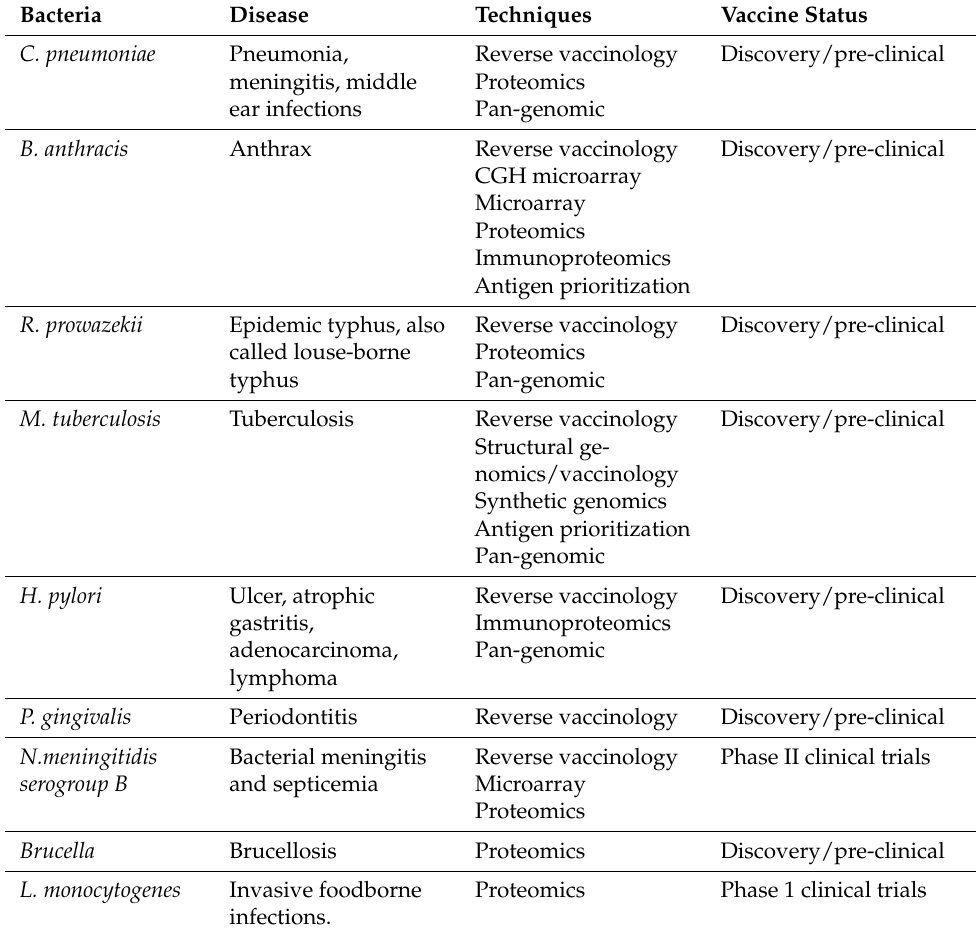
Table 4. Post genomics techniques for vaccines against intracellular bacterial infections, along with the current state of each vaccine’s development. Data were collected from Bambini and Rappuoli (2009)